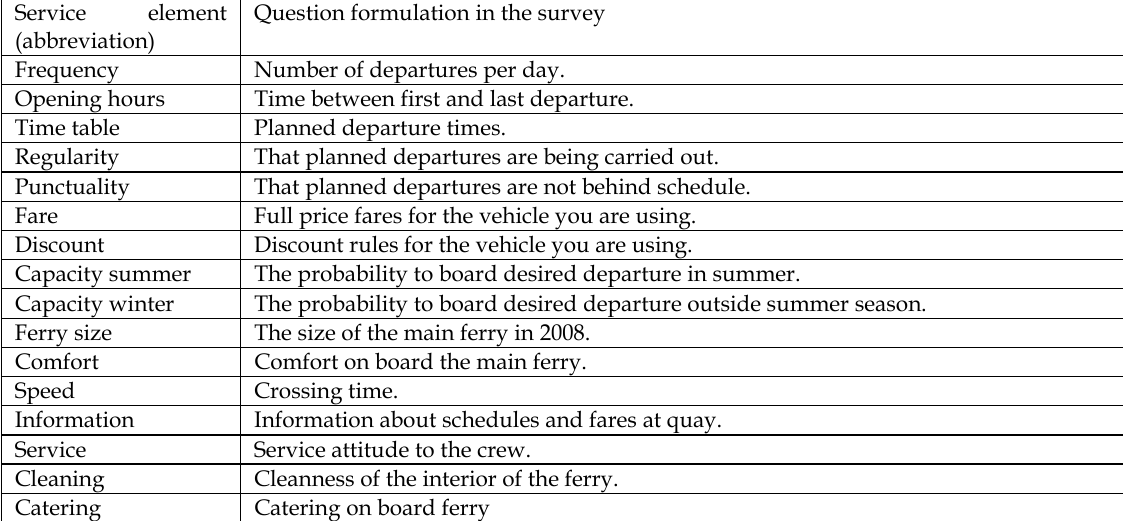
Table 2. Service elements for ferry transport (Source: Jørgensen et al.